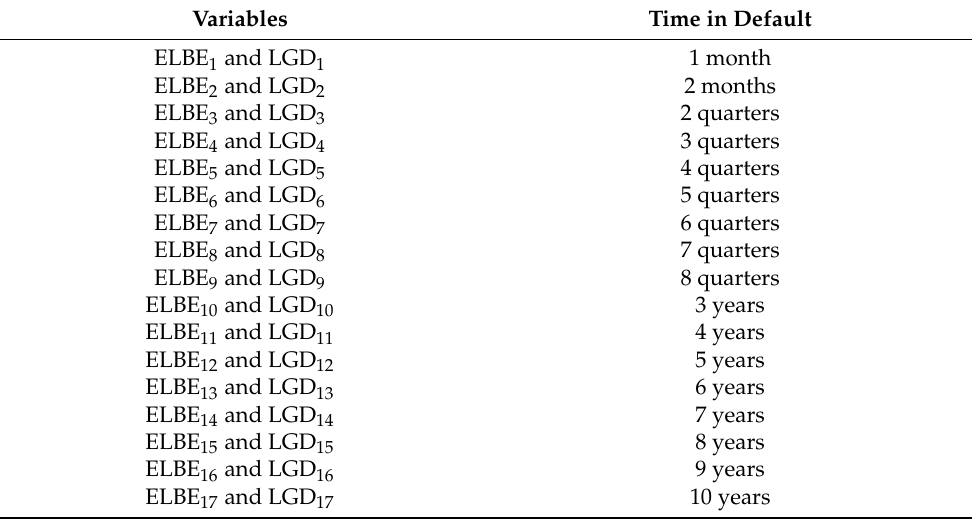
Table 2. Correspondence between ELBE and LGD in-default estimates and time in default.